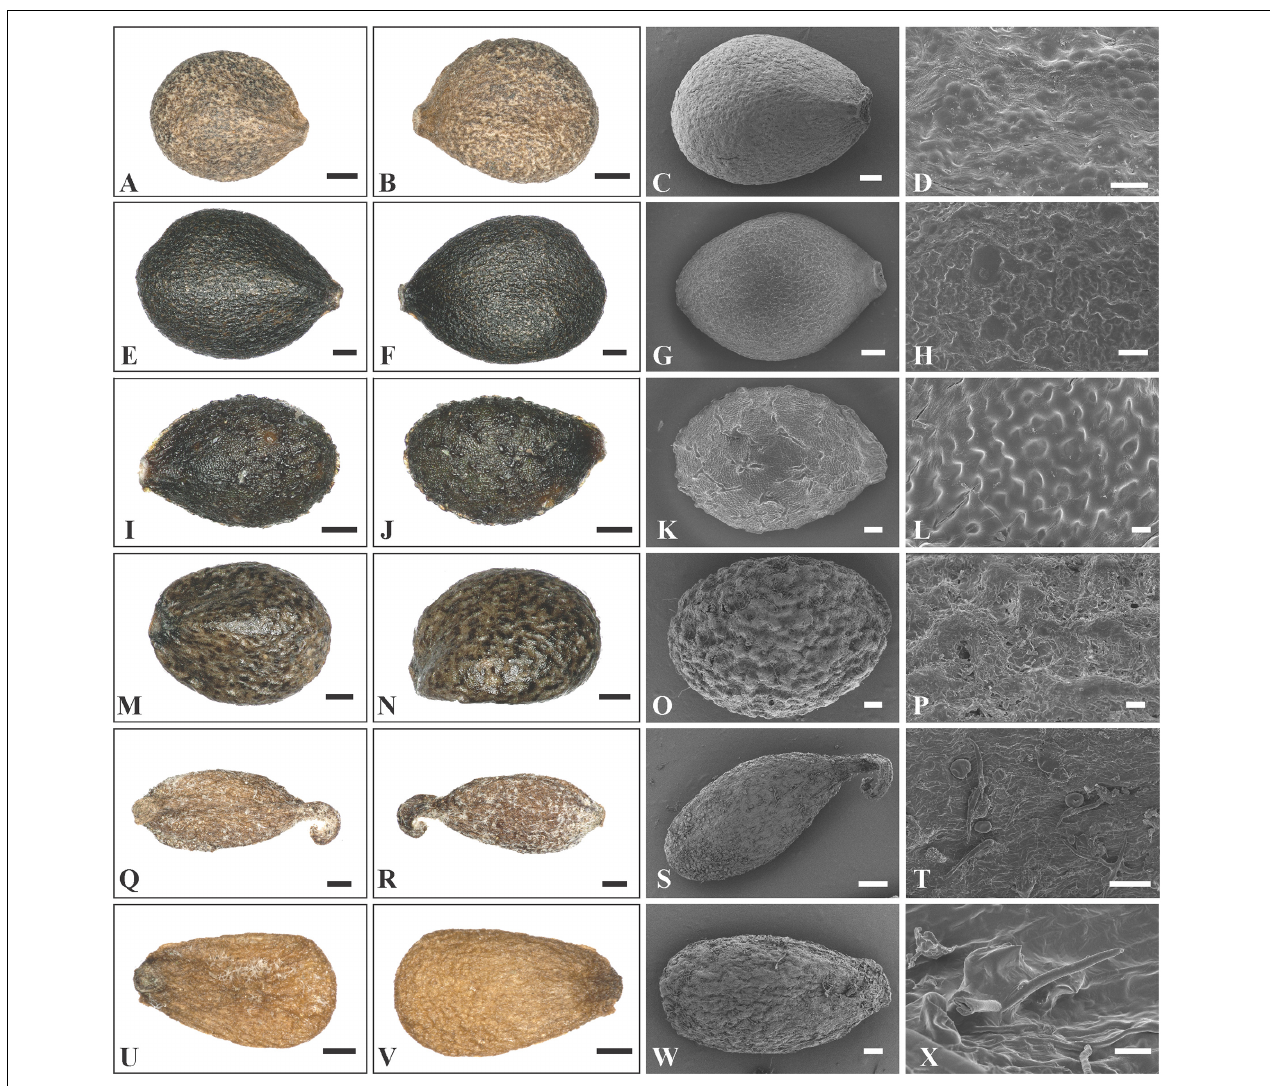
FIGURE 6 | LM and SEM micrographs of mericarps of Microtoena , Rostrinucula , and Comanthosphace . (A–D) M. delavayi ( Wang et al., SCSB-TBG-147 ), (E–H) Microtoena praineana ( Yi Sirong and Tan Qiuping, YISR432 ), (I–L) M. esquirolii ( Cai Jie and Zhang Ting, 12CS5726 ), (M–P) M. stenocalyx ( Li et al ., LiYL1849 ), (Q–T) Rostrinucula sinensis (Zhang Daigui, 3756 ), (U–X) Comanthosphace ningpoensis ( Zhu et al., ZhuXX121 ). — Scale bars: (A–B,Q–S,U–V) 400 µ m; (C,E–F,I–J,M–N,T,W) 200 µ m; (D) : 40 µ m, (G,K,O) 100 µ m; (H,L,P,X) 20 µ